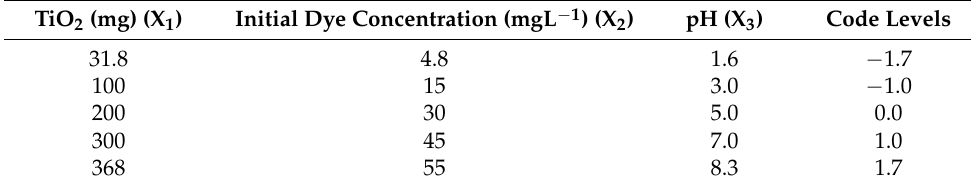
Table 2. Independent variable ranges and levels for synthesis of CS-TiO 2 -GLA